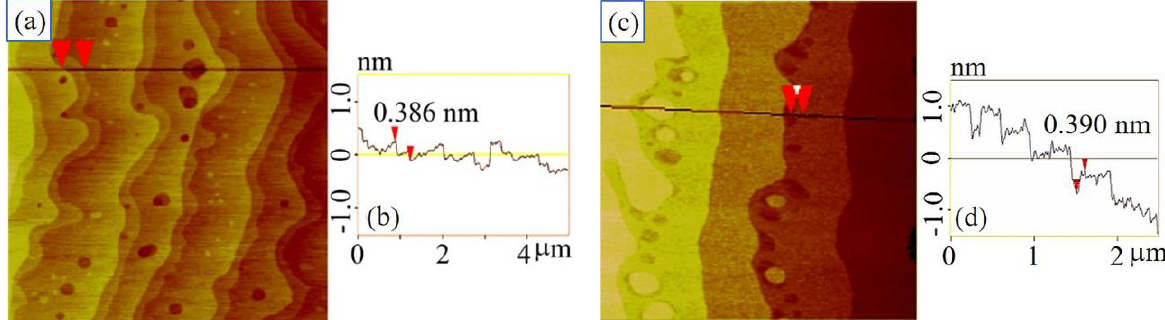
Figure 4. ( a , c ) Topographic AFM images and ( b , c ) the line scan profiles indicating incomplete etching ( a , b ) and etch pit formation ( c , d ) for: (001) NdGaO 3 substrate chemically etched for 2 min (m-BHF solution, pH = 5.5), in ( a , b ); (110) NdGaO 3 substrate chemically etched for 2 min (m-BHF solution, pH = 4.5), in (c and d). Chemical etching was followed by annealing for 2 h at 1000 °C in O 2 flow (200 L/h). AFM scans size: ( a ) 5 × 5 μm 2 and ( c ) 2.5 × 2.5 μm 2 .